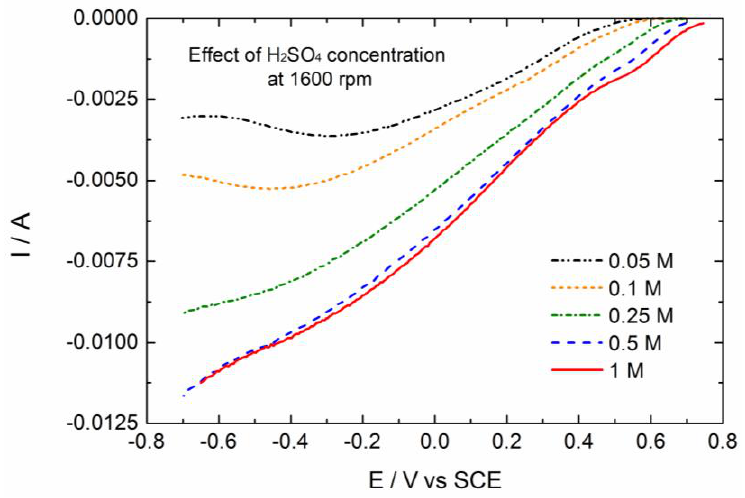
Figure 6. Current vs. potential LSV curves, recorded with a GC RDE electrode at 1600 rpm rotation speed and 20 mV.s −1 potential scan rate, in 0.05 M K 2 Cr 2 O 7 solutions of varied H 2 SO 4 concentra- tions.